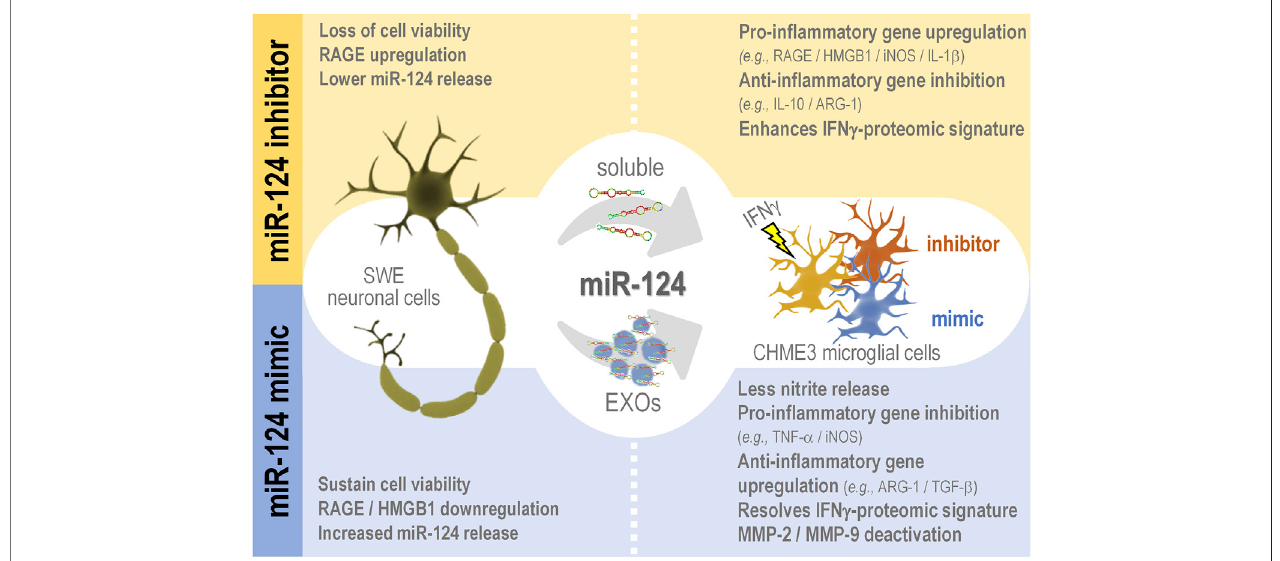
FIGURE9| SchematicrepresentationofthemiR-124traf fi ckingbetweenSWEcellsandIFN γ -MGandconsequencesassociatedwithmiR-124inhibition(inhibitor) and upregulation (mimic) in each cell type. miR-124 is transferred from the SWE cells to IFN γ -MG via neuronal secretome (either free or in EXOs). The neuronal miR-124 inhibition, apart from reducing its levels in SWE cells and their secretome, also compromises cell viability and induces RAGE upregulation upon coculture with IFN γ -MG. Besidestheeffects in theSWEcells, themiR-124inhibition leadstoparacrineeffectsinIFN γ -MG,including pro-in fl ammatory gene expression and IFN-associated proteomicsignature.Onthecontrary,themiR-124mimicupregulatesitsexpression/releasebySWEcells,whilesustainingcellviabilityinthepresenceofIFN γ -MGcells, whichinturnmanifestahomeostaticstatepro fi lewithlessnitrosativeactivity,predominantanti-in fl ammatorygene/proteomicsignature,andreducedextracellularmatrix degradation. Considering the progress in the fi eld of EXOs as miRNA carriers to alleviate pathological cellular states in several diseases, EXOs enriched in miR-124 may open a new avenue in therapeutic interventions in AD. miR, miRNA; RAGE, receptor for advanced glycation end products; HMGB1, high mobility group box protein 1; iNOS, inducible nitric oxide synthase; IL, interleukin; ARG-1, arginase-1; TNF- α , tumor necrosis factor α ; TGF- β , transforming growth factor β ; MMP,